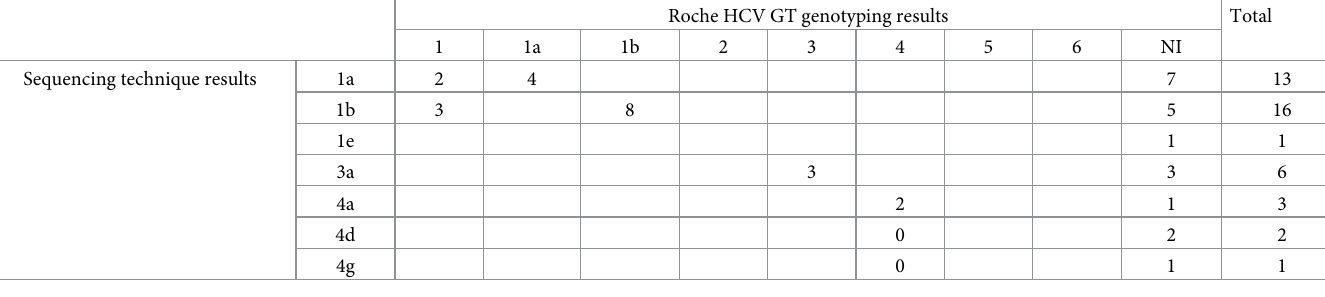
Table 4. Correspondence between results obtained with both techniques for the low viral load samples (n =